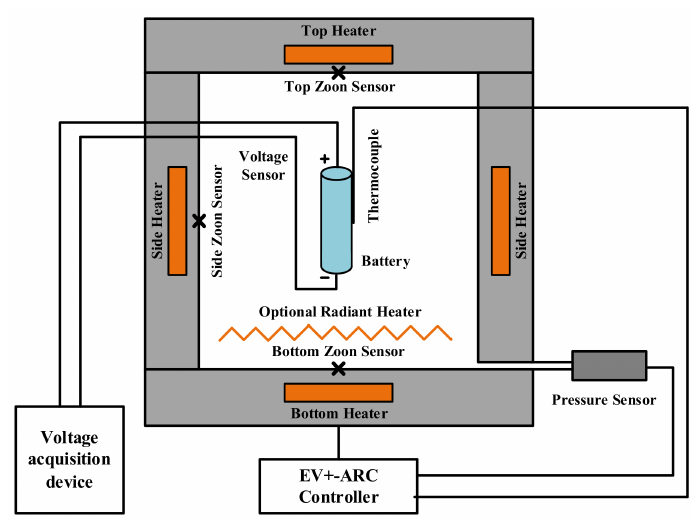
Figure 4. The specific heat capacity experiment.